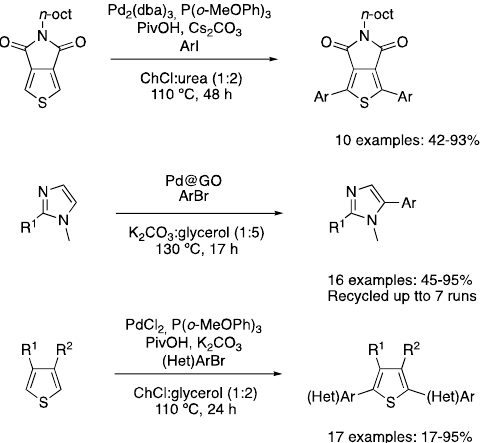
Figure 31. Direct arylation of heterocyclic arenes.